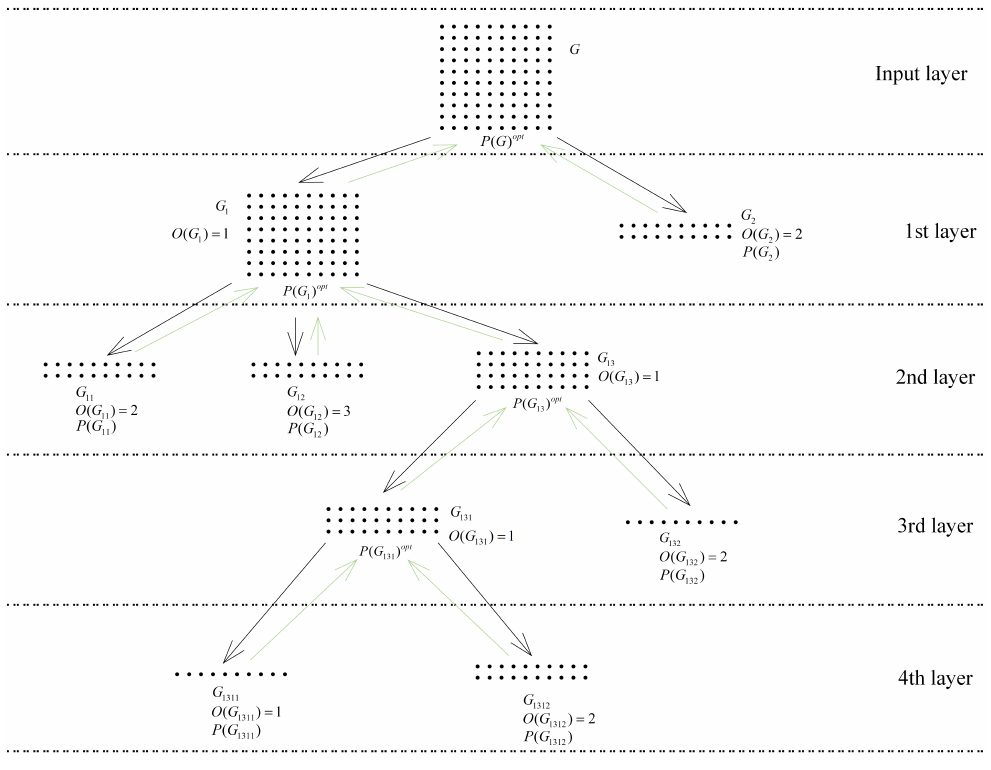
Figure 3. An example of the ALC_IGA on a 100 nodes instance. The black lines represent the solution initialization phase, and the green lines denote the solution optimization